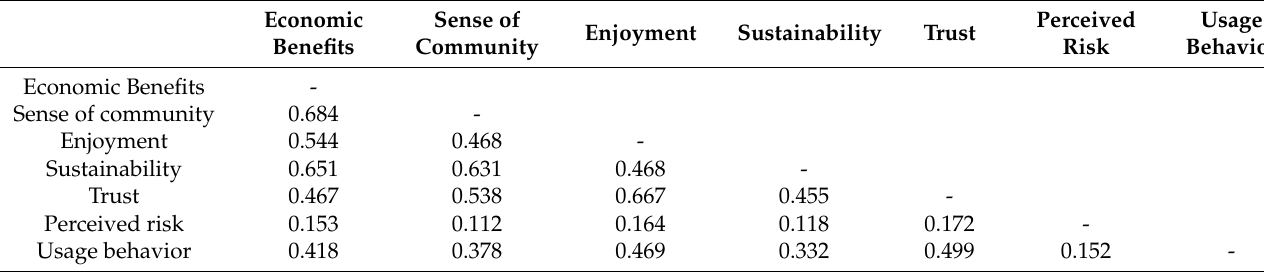
Table 5. Heterotrait–monotrait correlations